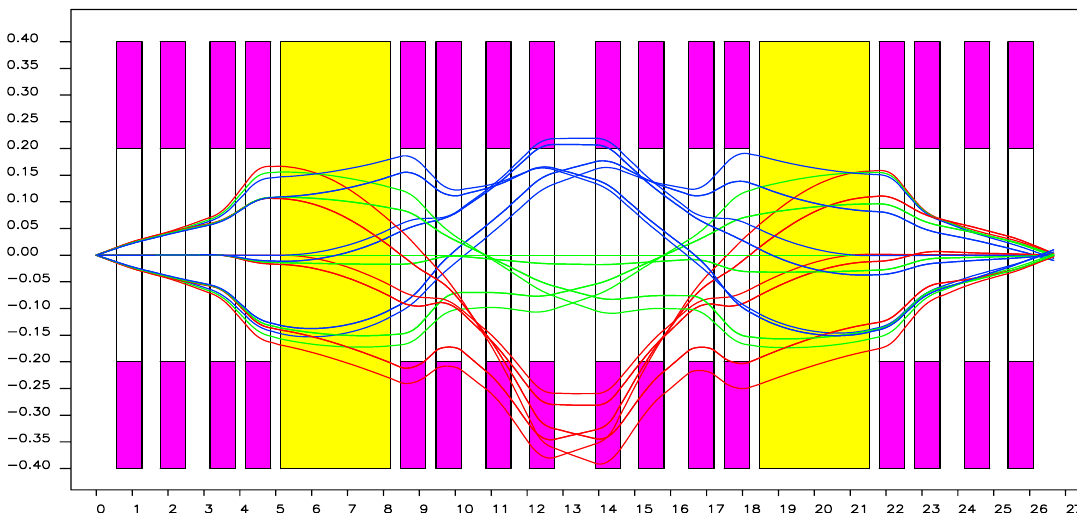
FIG. 6. (Color) Fifth order horizontal envelope corresponding to acceptance (initial beam emittance of (cid:10) 1 mm , (cid:10) 25 mrad horizontally and (cid:10) 50 mrad vertically, and (cid:10) 10% energy dispersion) of the solution shown in Figs.